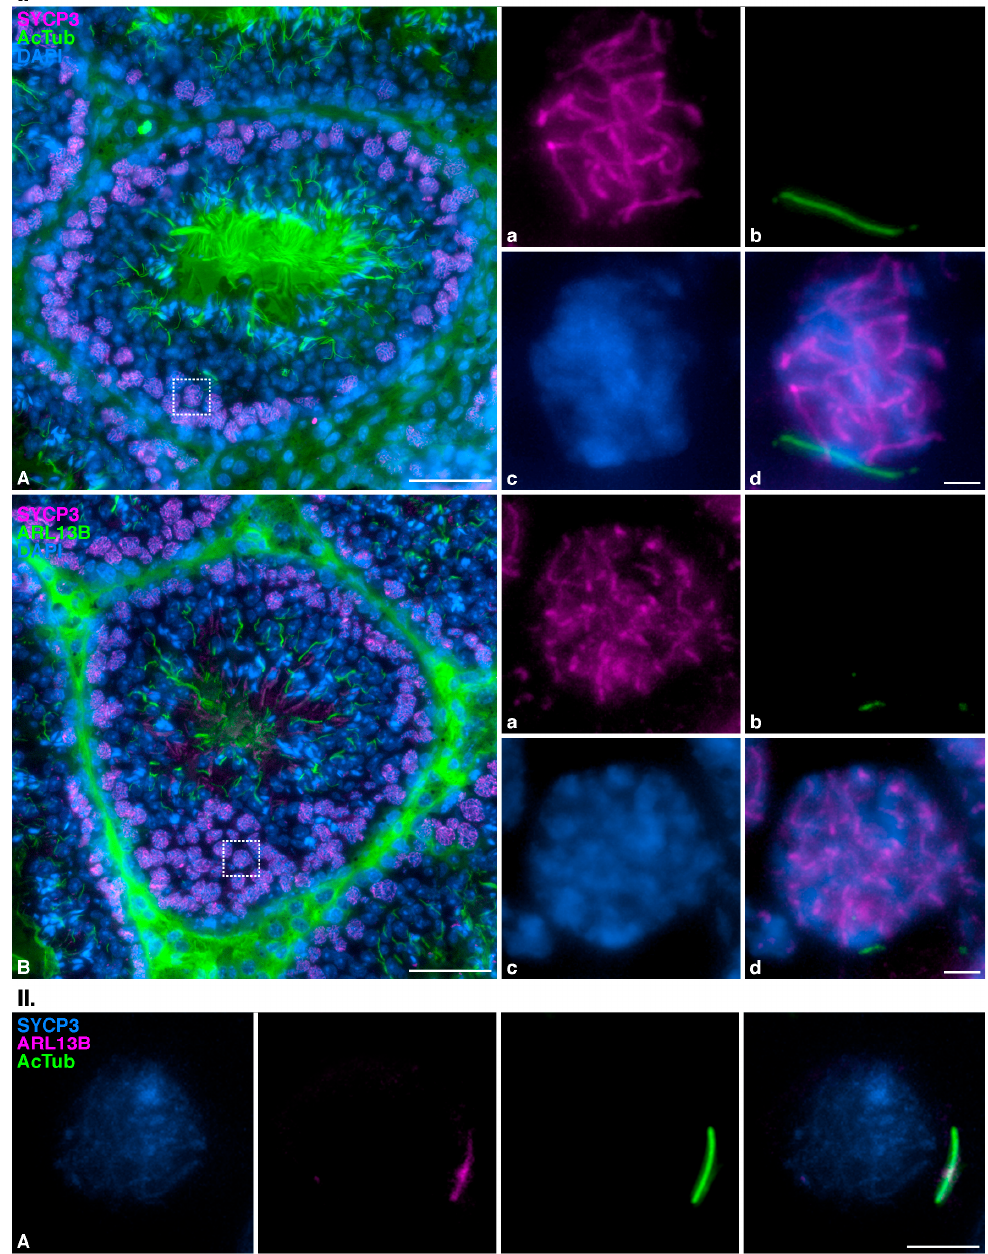
Figure 4. Zygotene cilia of mouse testis spermatocytes contain ARL13B. ( I ) : Distribution of acety- lated Tubulin and ARL13B in mouse testis cryosection. Double immunolabelling of SYCP3 (ma- genta) and acetylated Tubulin (AcTub) (green), with chromatin stained with DAPI (blue) on cryosec- tions of mouse testis. ( A ) Complete section of a seminiferous tubule, ( a – d ) magnified selected spermatocyte at zygotene (dotted square) showing a fully formed primary cilium, and double im- munolabelling of SYCP3 (magenta) and ARL13B (green), with chromatin stained with DAPI (blue) on cryosections of mouse testis. ( B ) Complete section of a seminiferous tubule, ( a – d ) magnified selected spermatocyte at zygotene (dotted square) showing an incipient polymerizing primary cilium. Scale bar in A and B represents 50 µ m, and scale bar in d represents 5 µ m. ( II ) : Distribution of ARL13B in mouse squashed spermatocytes at zygotene. Triple immunolabelling of SYCP3 (blue), ARL13B (magenta), and acetylated tubulin (AcTub) (green) on squashed WT mouse spermatocytes at zygotene ( A ). Scale bar represents 5 µ